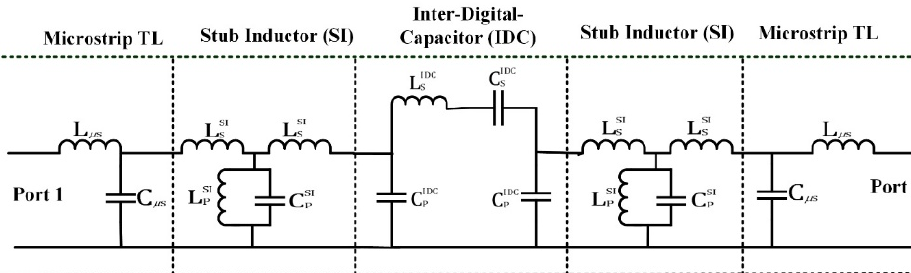
Figure 2. Equivalent circuit model of the P-CRLH unit cell.